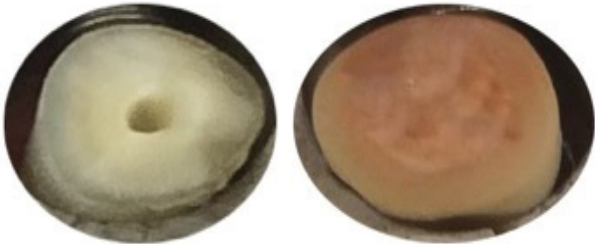
Figure 1. Precipitate formed after the association of the proposed